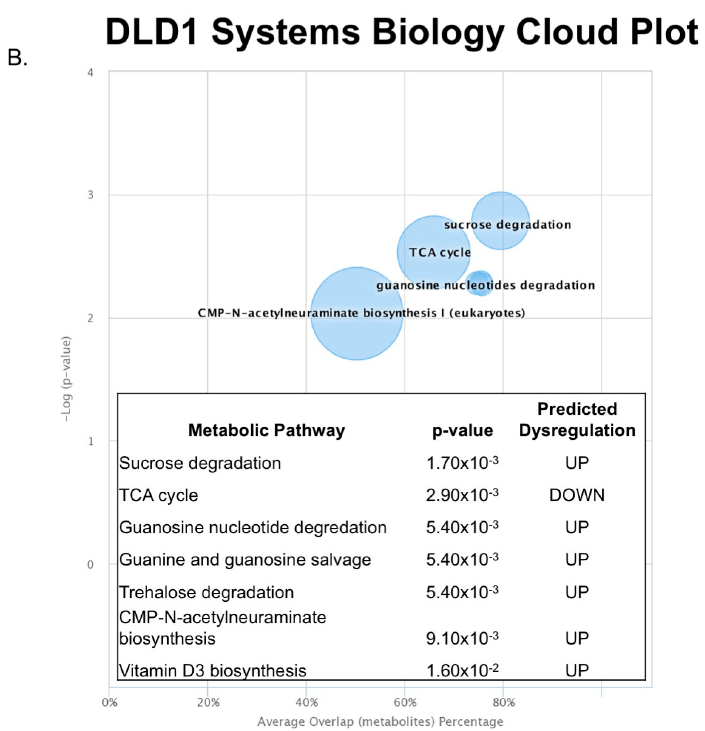
Figure 4. ( A ) XCMS online was used to compare metabolite differences between treated and untreated DLD-1 cells. A cloud plot was produced to compare features plotted on m / z (y-axis) and retention time (x-axis). XCMS identified 237 metabolites up or downregulated by treatment in DLD-1 cells, which are represented by green and red circles, respectively. Size and color of the circles correspond to the log fold change and p -value, respectively; ( B ) Using the 237 differential metabolites, XCMS maps the metabolites to metabolic pathways represented on a cloud plot. Pathways with greater percent overlap of metabolites and statistical significance will appear in the upper right corner of the cloud plot. Five pathways were found to have a p -value <0.01 and their predicted dysregulation is shown in the table.